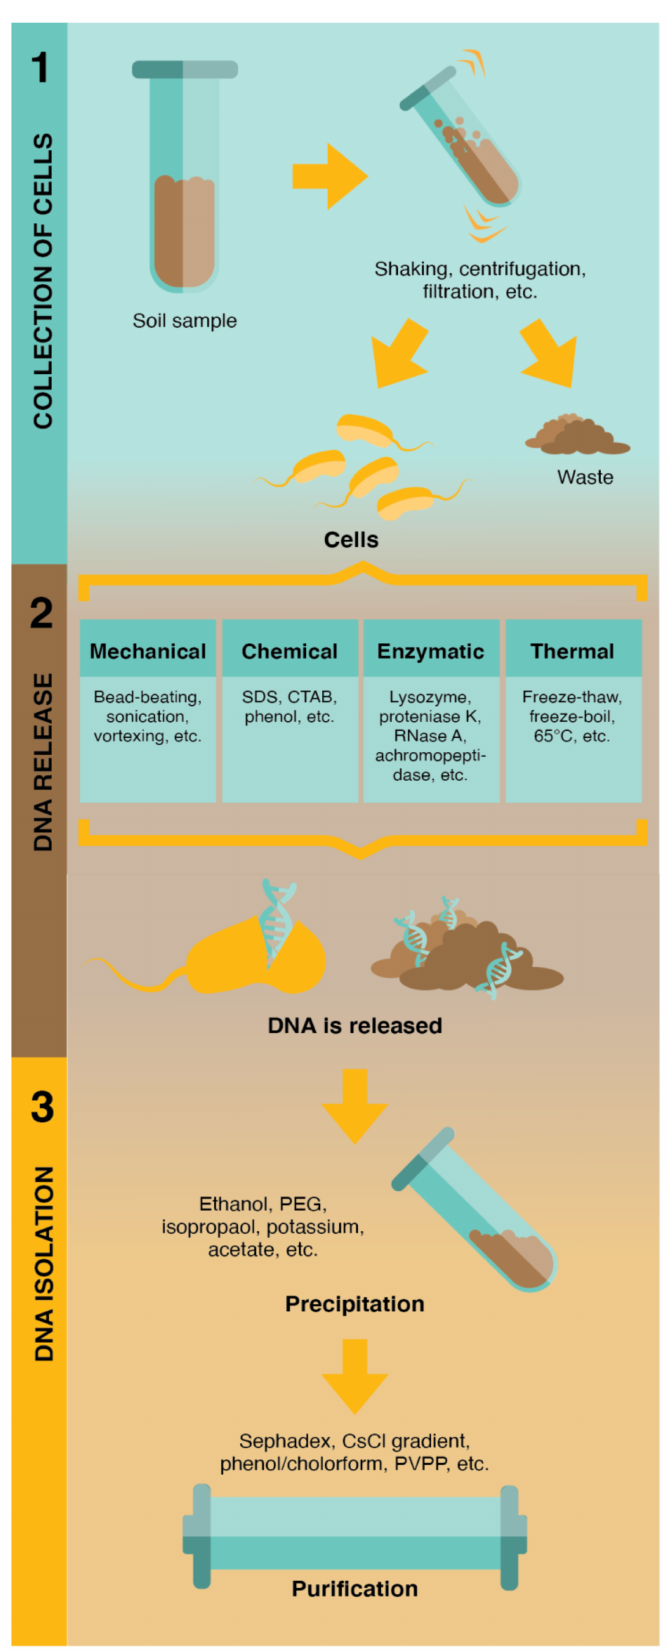
Figure 3. The three steps of environmental DNA extraction: 1. isolation of the cell fraction, 2. cell lysis and DNA release, 3. DNA